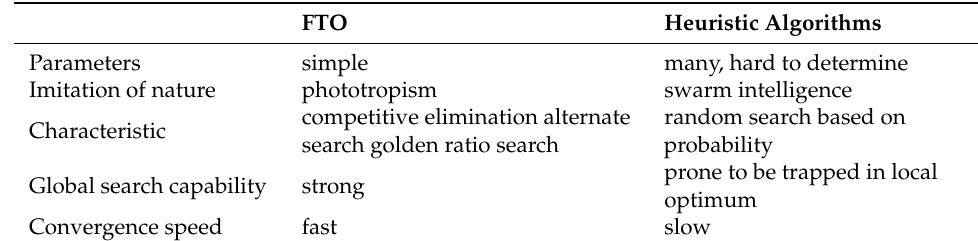
Table 5. The comparison between FTO and other optimization algorithms.